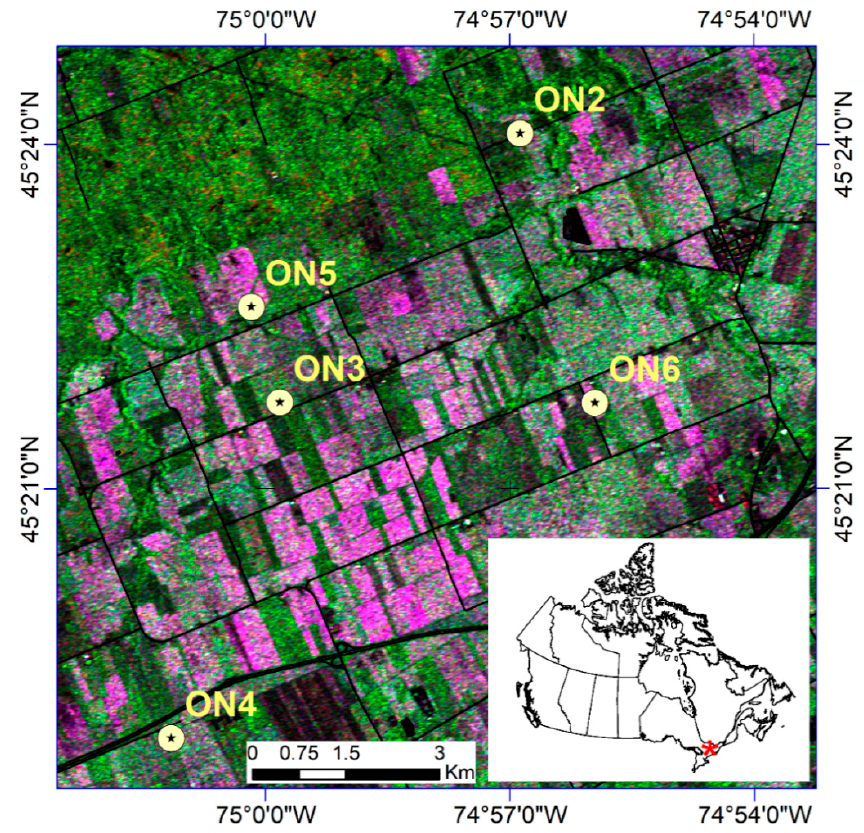
Figure 1. Location of the study site and the Real-Time In-Situ Soil Monitoring for Agriculture (RISMA) in-situ network in eastern Ontario. ON1 station was decommissioned in the fall of 2015. The background is a RADARSAT-2 image acquired on 6 June 2006.